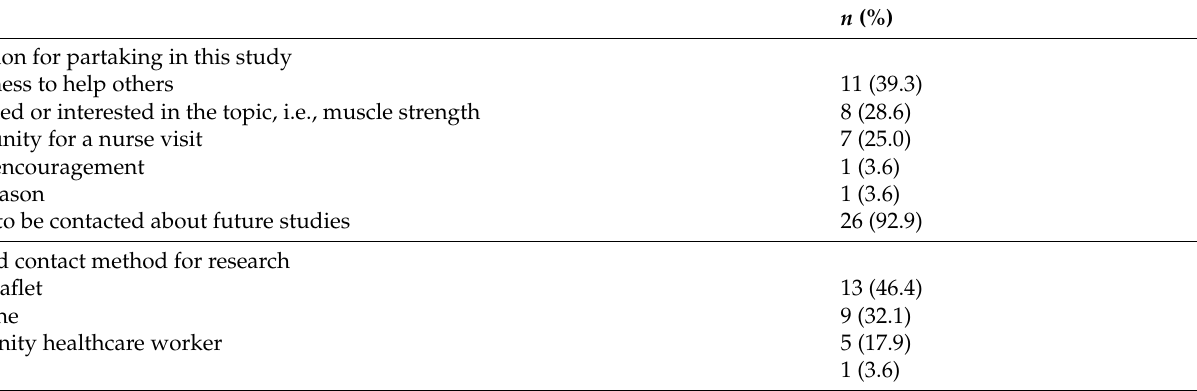
Table 3. Participant Feedback on Engaging in Future Research Studies ( n =